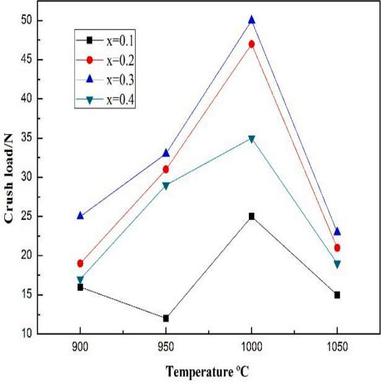
The average crush load of Li4(Si,Ti)O4 pebbles as function of temperature.